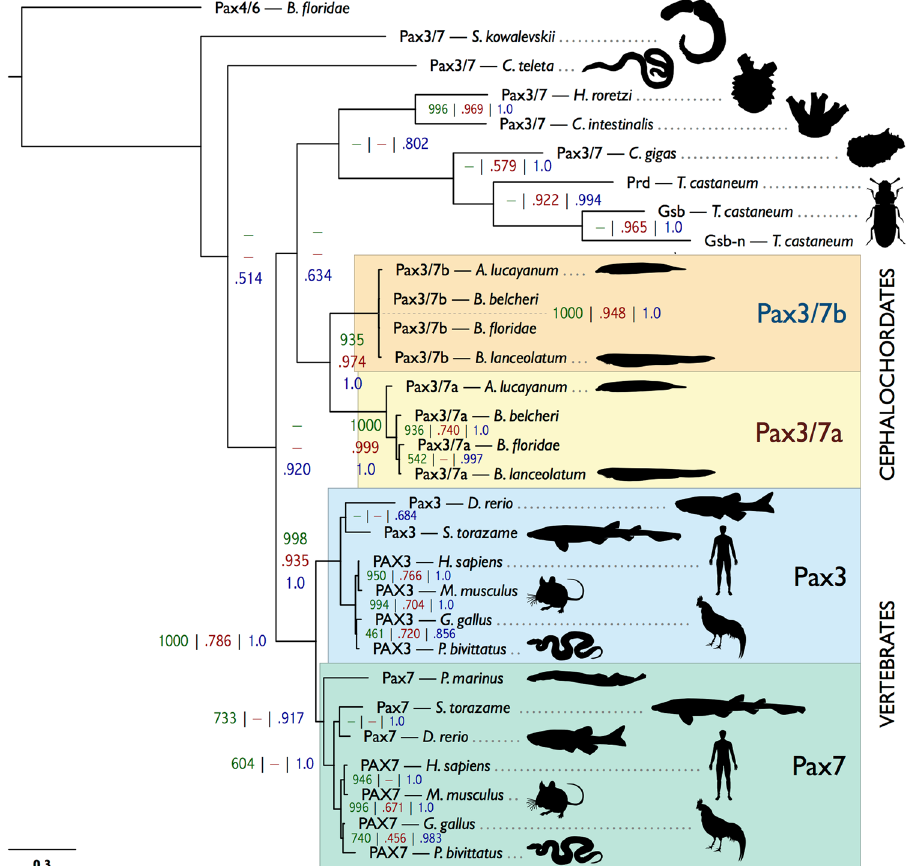
Figure 2. Bayesian tree of Pax3/7 genes. Support values are presented as follows: bootstraps out of 1000 from PHYLIP (dark green) | bootstraps out of 1.0 from equivalent nodes from maximum likelihood (dark red) | posterior probabilities from equivalent nodes from a Bayesian analysis (dark blue). Absence of an equivalent node in the corresponding analysis is indicated by a dash. The accession numbers of all included sequences are reported in Supplementary Table S2 (Supplementary File 1). The scale bar in the lower left corner indicates amino acid substitutions per site. B . floridae = Branchiostoma floridae ; S . kowalevskii = Saccoglossus kowalevskii ; C . teleta = Capitella teleta ; H . roretzi = Halocynthia roretzi ; C . intestinalis = Ciona intestinalis ; C . gigas = Crassostrea gigas ; T . castaneum = Tribolium castaneum ; A . lucayanum = Asymmetron lucayanum ; B . belcheri = Branchiostoma belcheri ; B . lanceolatum = Branchiostoma lanceolatum ; D . rerio = Danio rerio ; S . torazame = Scyliorhinus torazame ; H . sapiens = Homo sapiens ; M . musculus = Mus musculus ; G . gallus = Gallus gallus ; P . bivitattus = Python bivitattus ; P . marinus = Petromyzon marinus